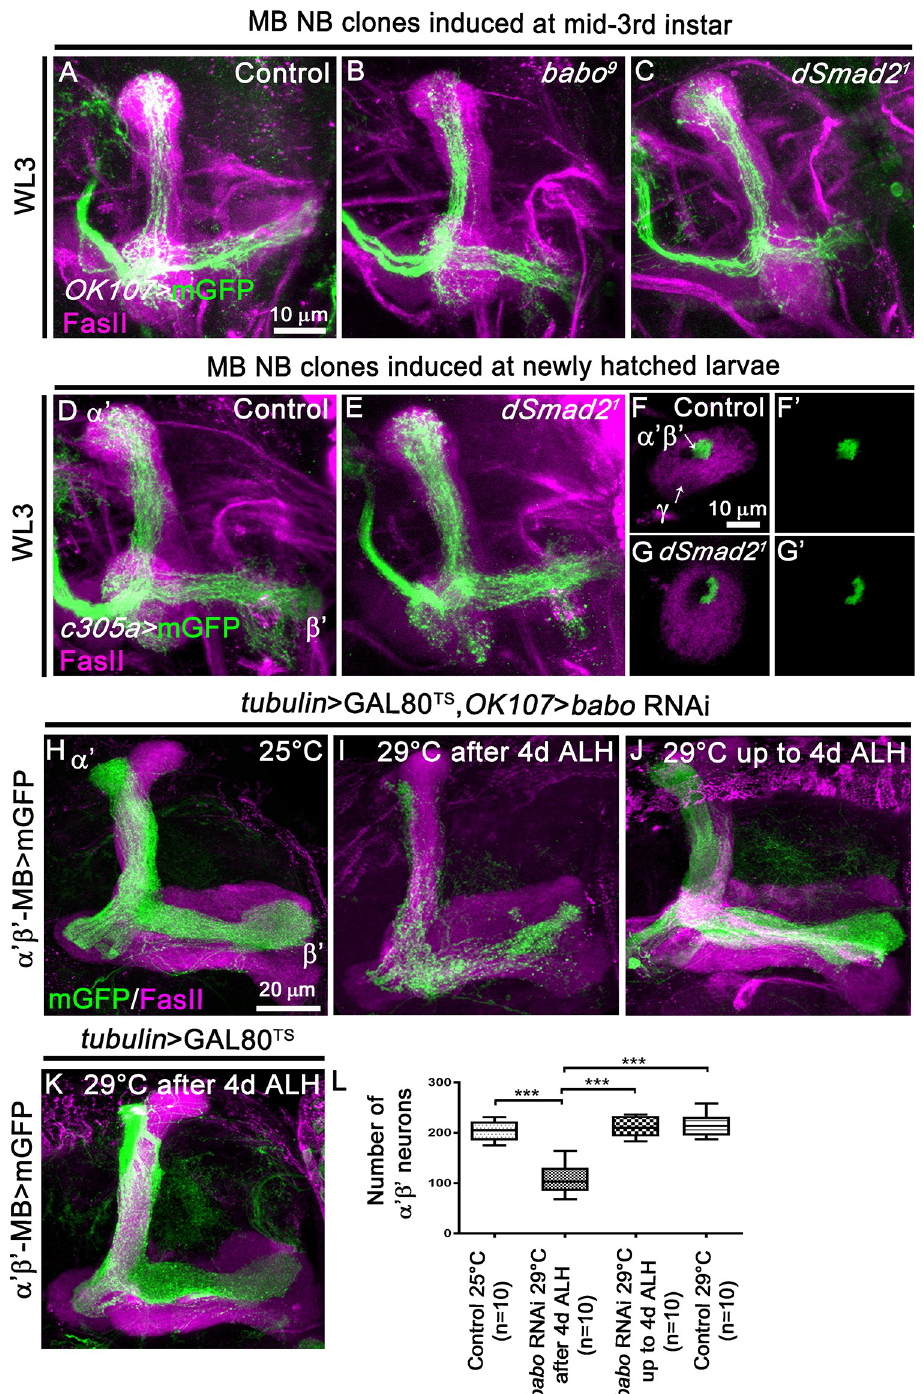
Fig 2. TGF- β signalling is dispensable for the initial α ’ β ’ MB neuron production. (A-C) WL3 MB lobes from control (A) (n = 8), babo 9 (B) (n- = 7) and dSmad2 1 (C) (n = 12) MARCM NB clones induced at mid-third instar stage, labelled with mGFP (green) using the GAL4- OK107 driver and stained with anti-FasII antibody (magenta). (D, E) WL3 MB lobes from control (D) (n = 5) and dSmad2 1 (E) (n = 9) MARCM NB clones generated in newly hatched larvae, labelled with mGFP (green) using the α ’ β ’-specific GAL4- c305a driver and stained with anti-FasII antibody (magenta). (F-G’) Cross sections of control (F,F’) and dSmad2 1 (G,G’) WL3 MB peduncles from neuroblast MARCM clones generated in newly hatched larvae labelled with mGFP (green) using the GAL4-c305a driver and stained